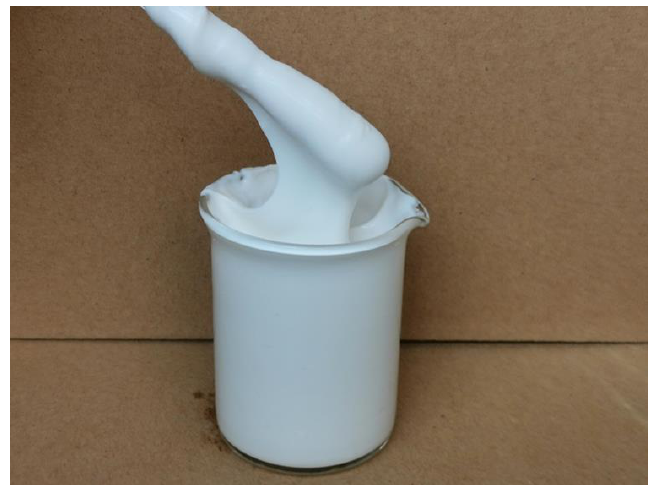
Figure 1. Aqua-dispersing nano-binder (ADNB).